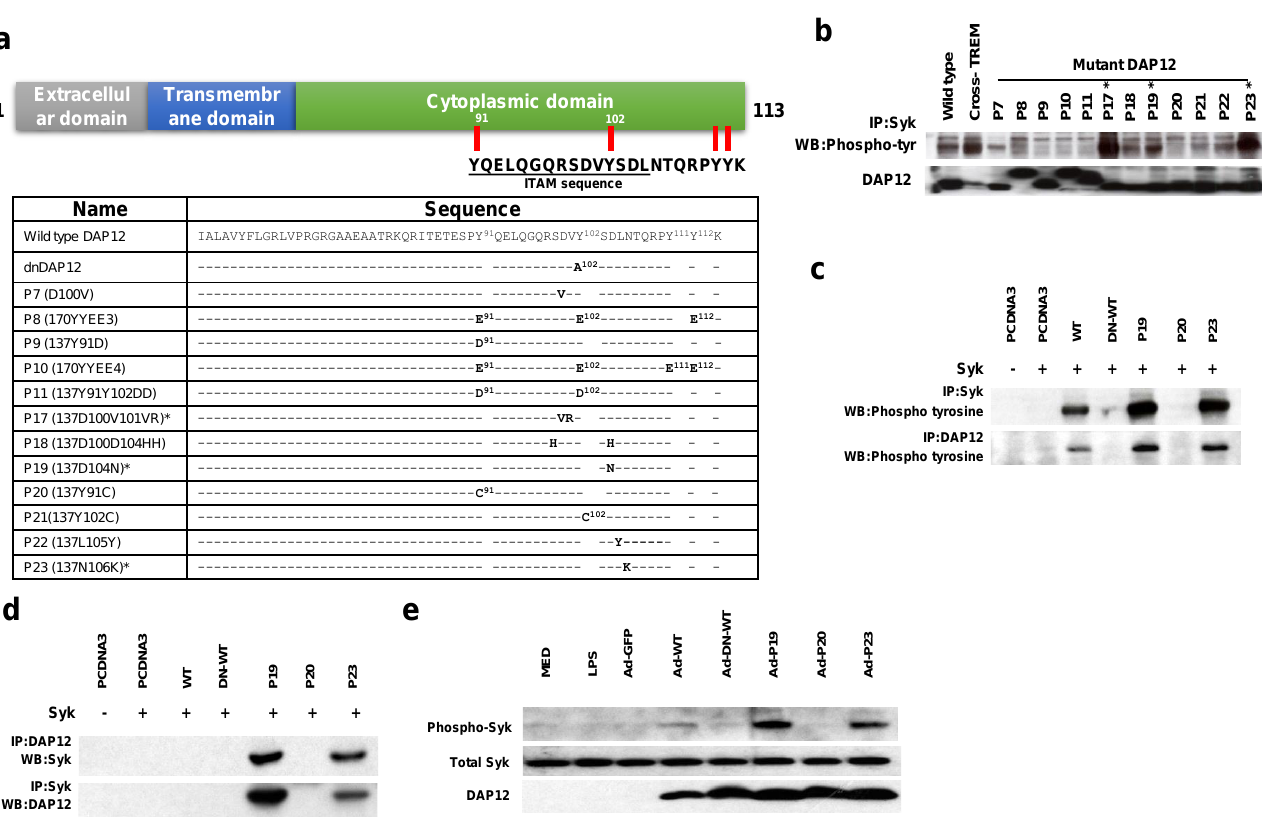
Figure 1. Constitutively active DAP12 associates with and activates Syk in AD293 cells: ( a ) Schematic representation of DAP12 mutations; ( b ) Immunoblot analysis of Syk tyrosine phosphorylation in Syk-overexpressing-AD293 cells transfected with wild-type (WT), dominant negative (DN) DAP12 [21] or mutant DAP12 (P7, P8, P9, P10, P11, P17, P18, P19, P20, P21, P22, and P23) and detected by a pan-phospho-Tyrosine antibody (4G10). Cross-linking of TREM1 in WT DAP12 transfected cells serves as a positive control for Syk activation; ( c ) AD293 cells were co-transfected with pcDNA3-Syk and either WT or mutant DAP12 (P19, P20, and P23) were IP for Syk or DAP12 and WB with anti-phospho-Tyrosine antibody; ( d ) Co-immunoprecipitation of DAP12 and Syk. IP, of either Syk or DAP12, to assess the association of DAP12 and Syk respectively. ( e ) Human monocyte-derived dendritic cells (MoDCs) were transduced with Ad constructs containing either: GFP, WT DAP12, DN-WT, P19, P20, P23, or lipopolysaccharide (LPS) (2 µ g/mL) for 48 prior to WB for Syk Tyr525/526, total Syk, or DAP12. Untreated cells (MED) or LPS treated cells are also